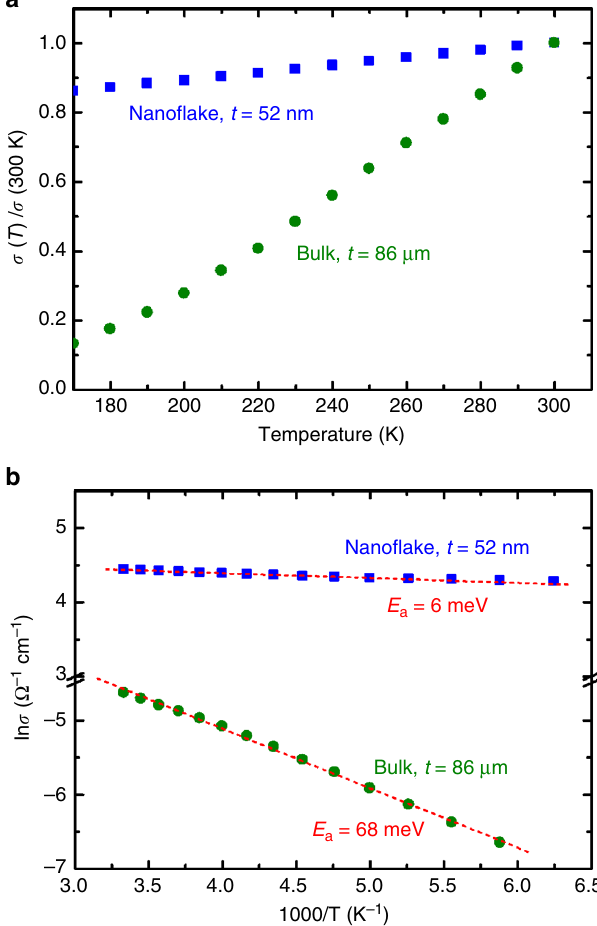
Fig. 3 Temperature-dependent conductivities in MoS 2 nano fl akes and bulks. a Temperature-dependent conductivity, σ ( T ), curves and b their corresponding Arrhenius plots for an MoS 2 nano fl ake ( t = 52 nm) and a bulk crystal ( t = 86 μ m). The σ ( T ) values of the MoS 2 nano fl ake and bulk in a were normalized by their corresponding conductivity values at 300 K, σ (300 K), to present the difference in σ between the nano fl ake and the bulk. The red dashed lines show the fi tting lines of the Arrhenius slopes for